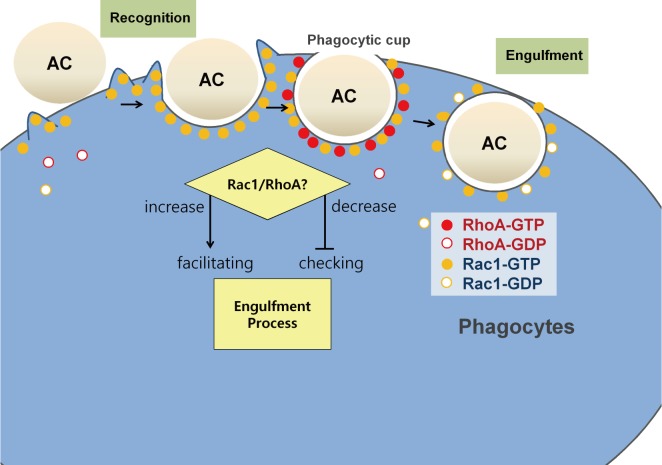
Schematic diagram of Rac1/RhoA balance for engulfment control.